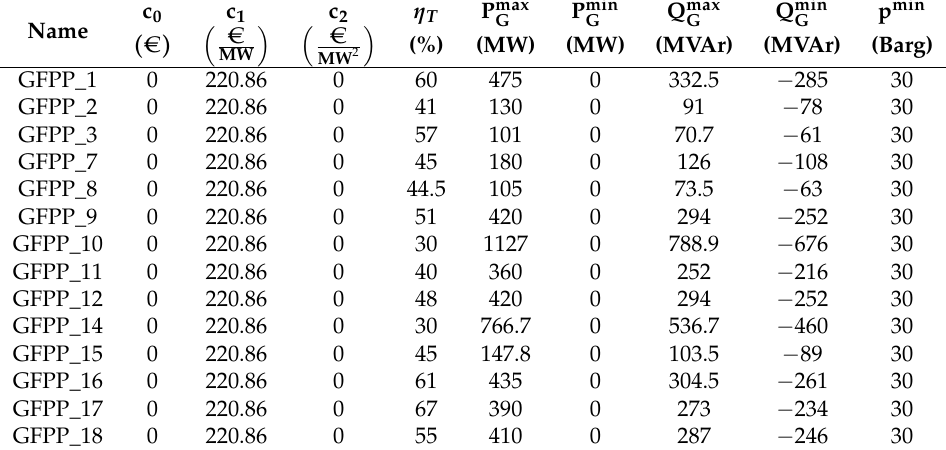
Table 5. Input data for GFPPs connected to the gas and electric power system. Numbering of GFPPs corresponds to the numbering of the solid interconnection lines in Figure